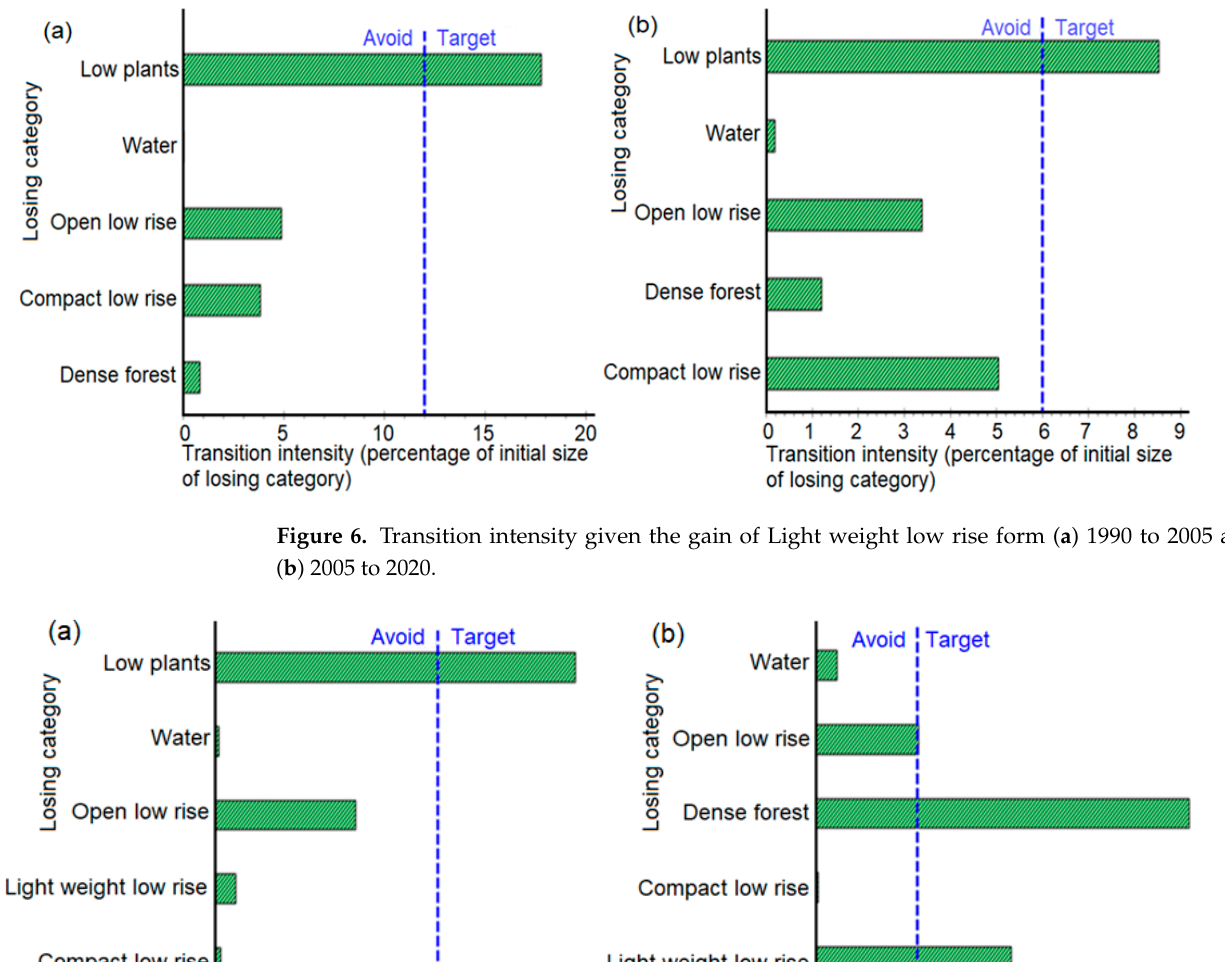
Figure 5. Transition intensity given gain of Compact low rise from ( a ) 1990 to 2005 and ( b ) 2005 to 2020.